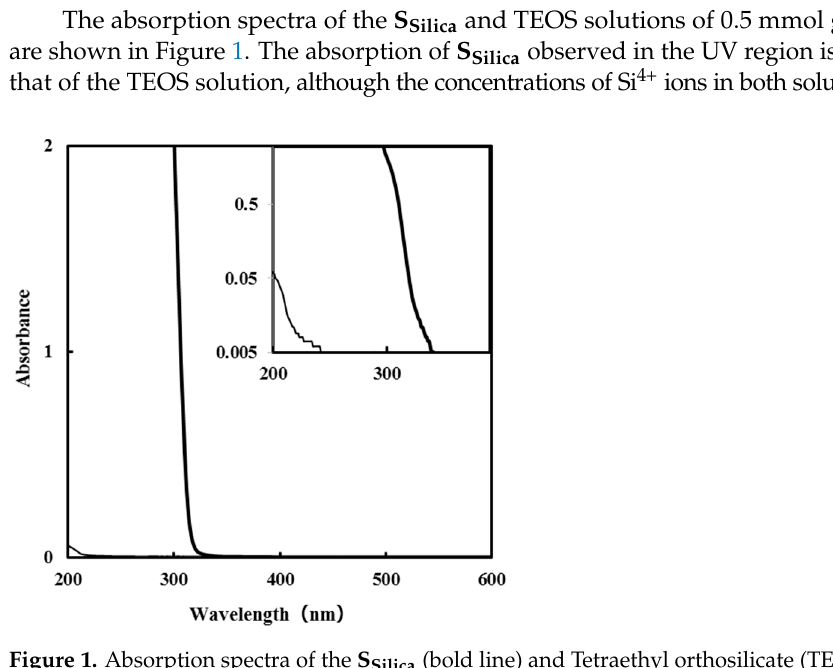
Figure 1. Absorption spectra of the S Silica (bold line) and Tetraethyl orthosilicate (TEOS) solutions in ethanol (thin line). The concentrations (0.5 mmol g − 1 ) of Si 4+ ions are identical to each other. The inset plotted the absorbance on a semi-log scale.